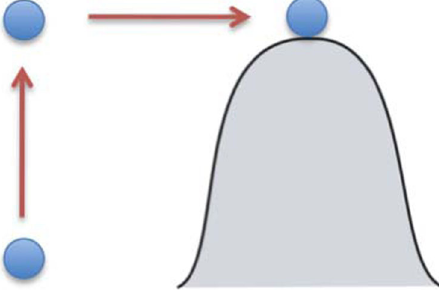
FIG. 4. Scenario from Mr. Brown ’ s conversation with